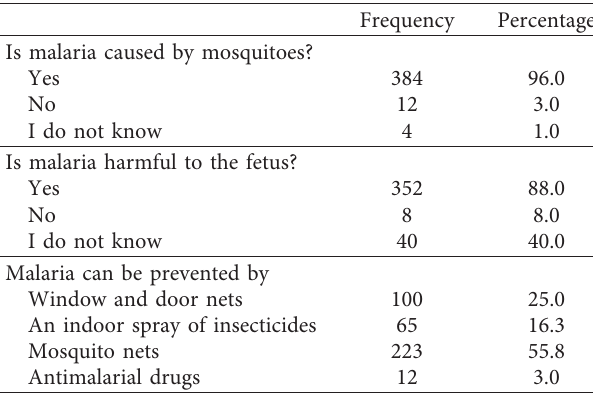
Table 2: Knowledge about